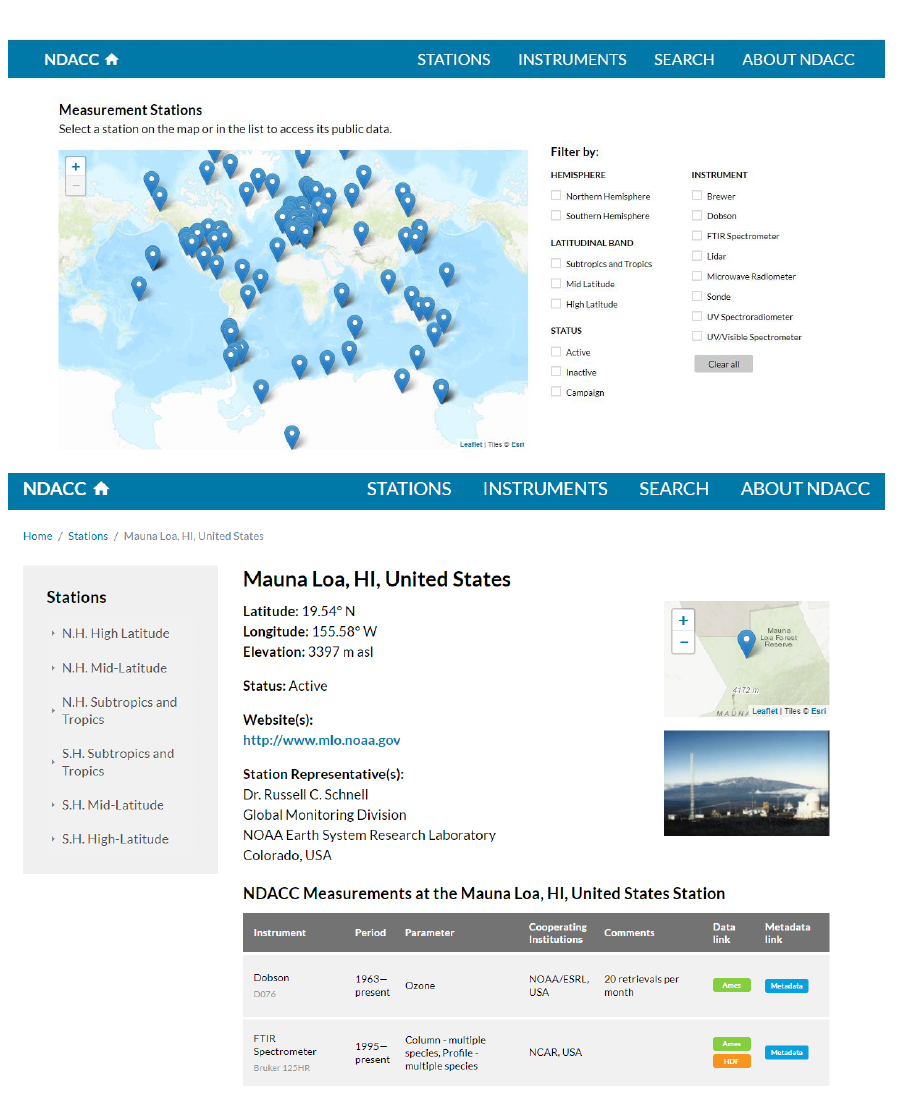
Figure 4. The newly redesigned NDACC website at www.ndacc.org (last access: 2 April 2018). (a) Stations are searchable by a dynamic map with filters. (b) Station pages allow direct access to data and metadata instrument description